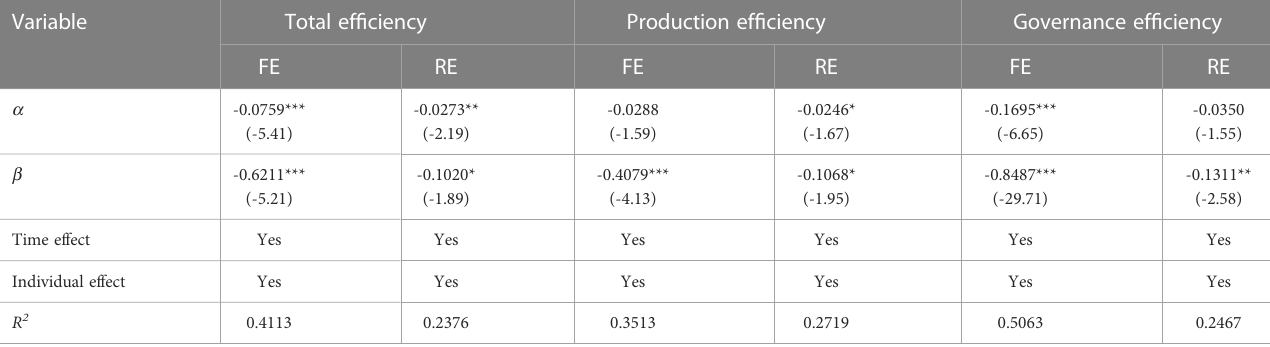
TABLE 4 Absolute b convergence results of marine green economy ef fi ciency at different stages.